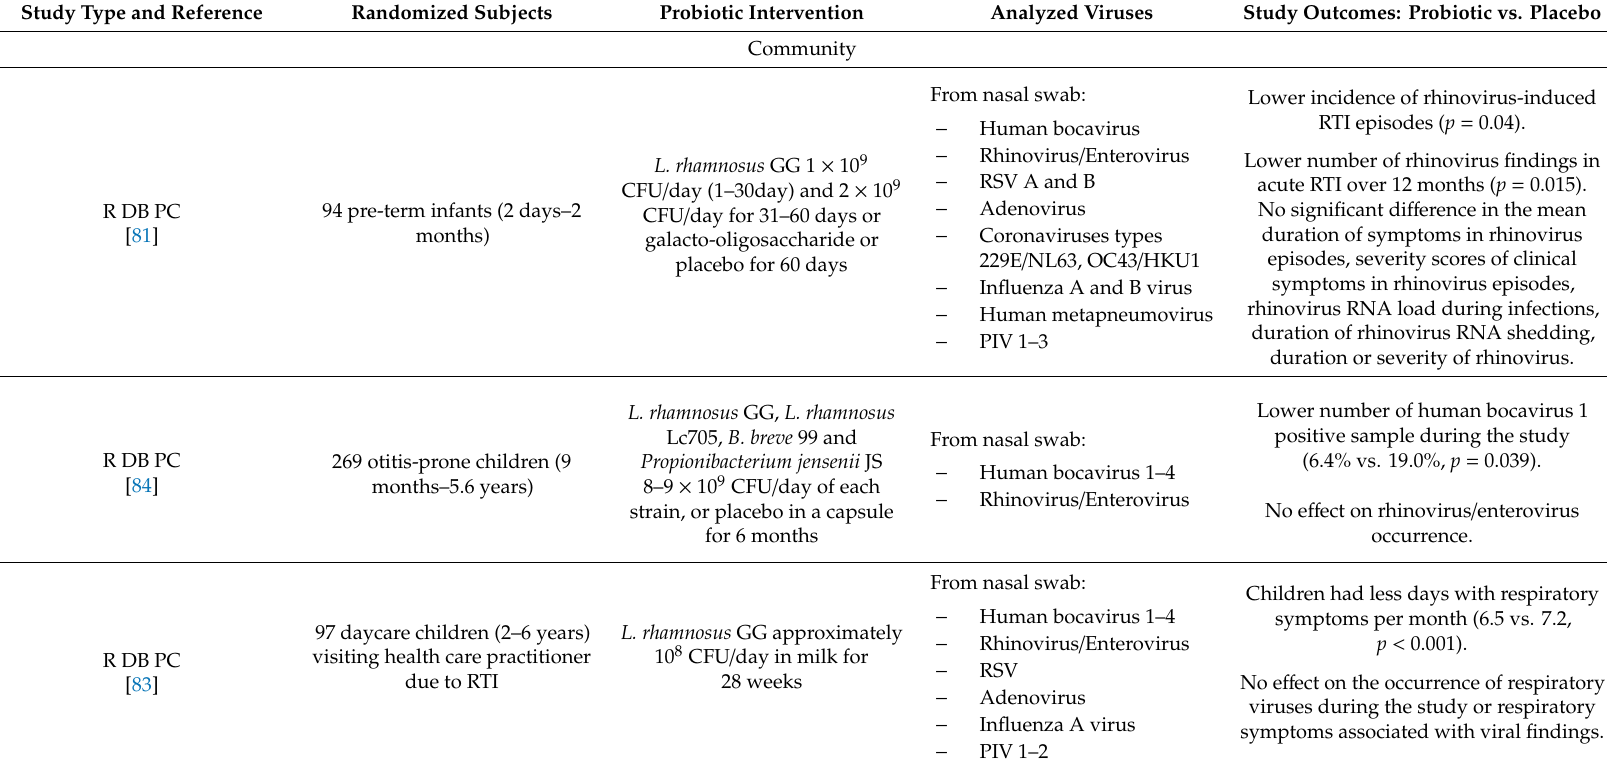
Table 2. Probiotic clinical trials investigating respiratory infection